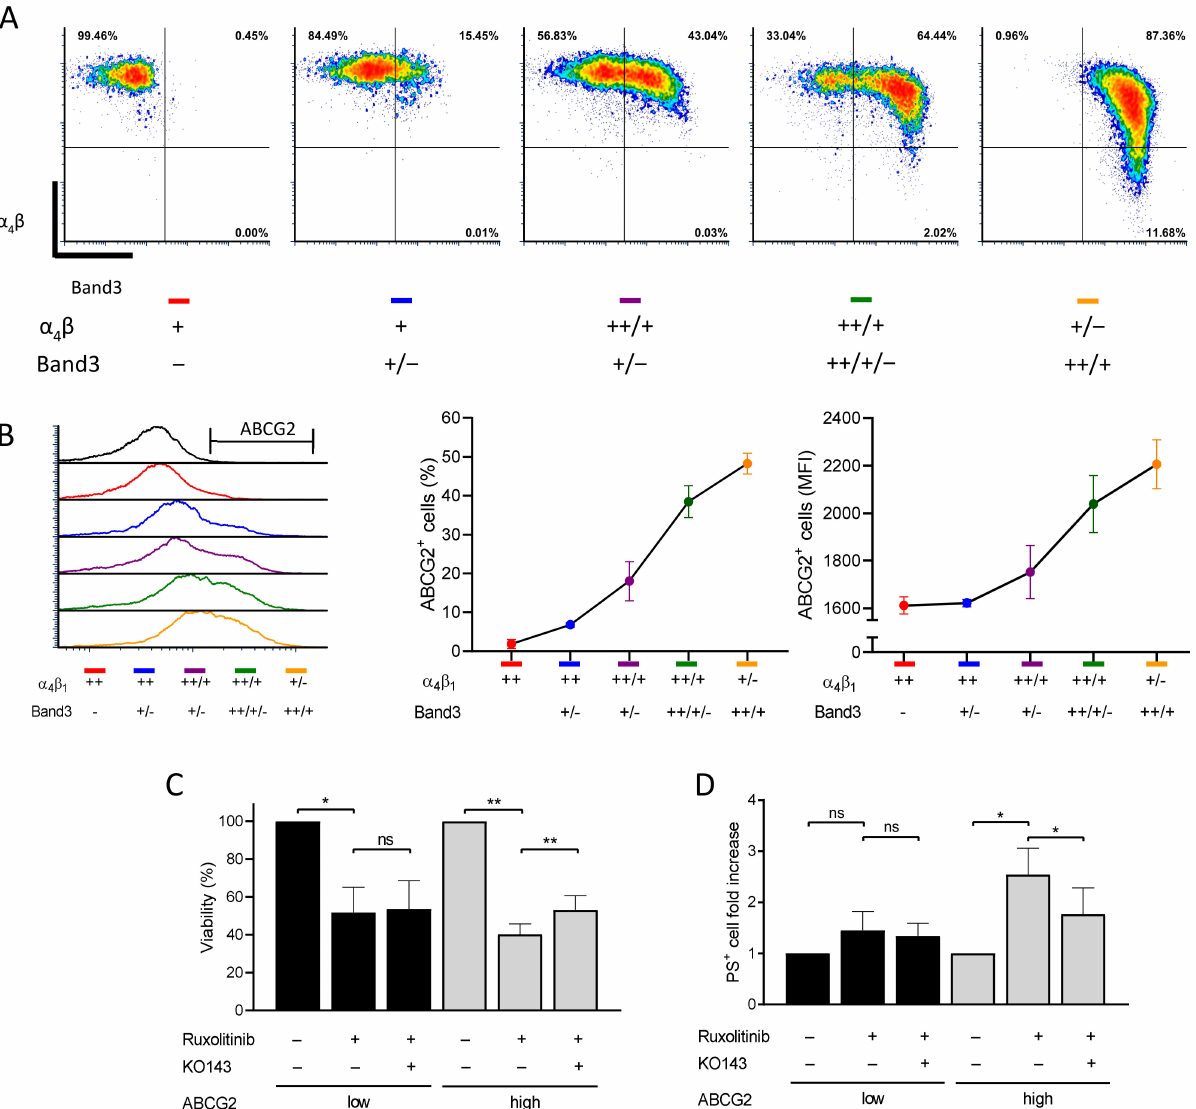
Figure 5. ABCG2 inhibition reduces ruxolitinib-induced apoptosis and PS exposure during human in vitro terminal erythroid differentiation. ( A ) Flow cytometry analysis of in vitro differentiated human erythroid cells. The in vitro cultured erythroblasts were labelled for GPA, α 4 integrin, band 3, and 7AAD. Representative plots of α 4 versus band 3 of all GPA-positive and 7AAD-negative cells are shown depending on the α 4 and band 3 expression levels: ++ (high), + (low), − (negative). ( B ) Flow cytometry analysis of ABCG2 expression on the cell surface at different stages of in vitro human terminal erythroid differentiation. The ABCG2 levels are presented depending on the α 4 and band 3 expression levels: ++ (high), + (low), − (negative). Left: ABCG2 histogram overlays; center: ABCG2-positive cells; right: mean fluorescence intensity (MFI) of ABCG2-positive RBCs. Means with SDs, N = 3. ( C ) Viability of in vitro differentiated human erythroid cells treated with 0.1 µ M ruxolitinib with or without 1 µ M KO143 pre-treatment. The viability was measured by CCK8. The data are presented at early (low ABCG2; black) and late (high ABCG2; grey) stages and are normalized with the viability of DMSO-treated cells as 100%. Means with SDs, N = 3, ratio paired t -test, ns – not significant, * p < 0.05, ** p < 0.01. ( D ) PS exposure at the surface of in vitro differentiated human erythroid cells treated with 0.1 µ M ruxolitinib with or without 1 µ M KO143. PS exposure was measured by flow cytometry using an annexin V kit. The data are presented at early (low ABCG2; black) and late (high ABCG2; grey) stages and are normalized with the PS exposure levels of DMSO-treated cells as 1. Means with SDs, N = 3, ratio paired t -test, ns – not significant, * p <